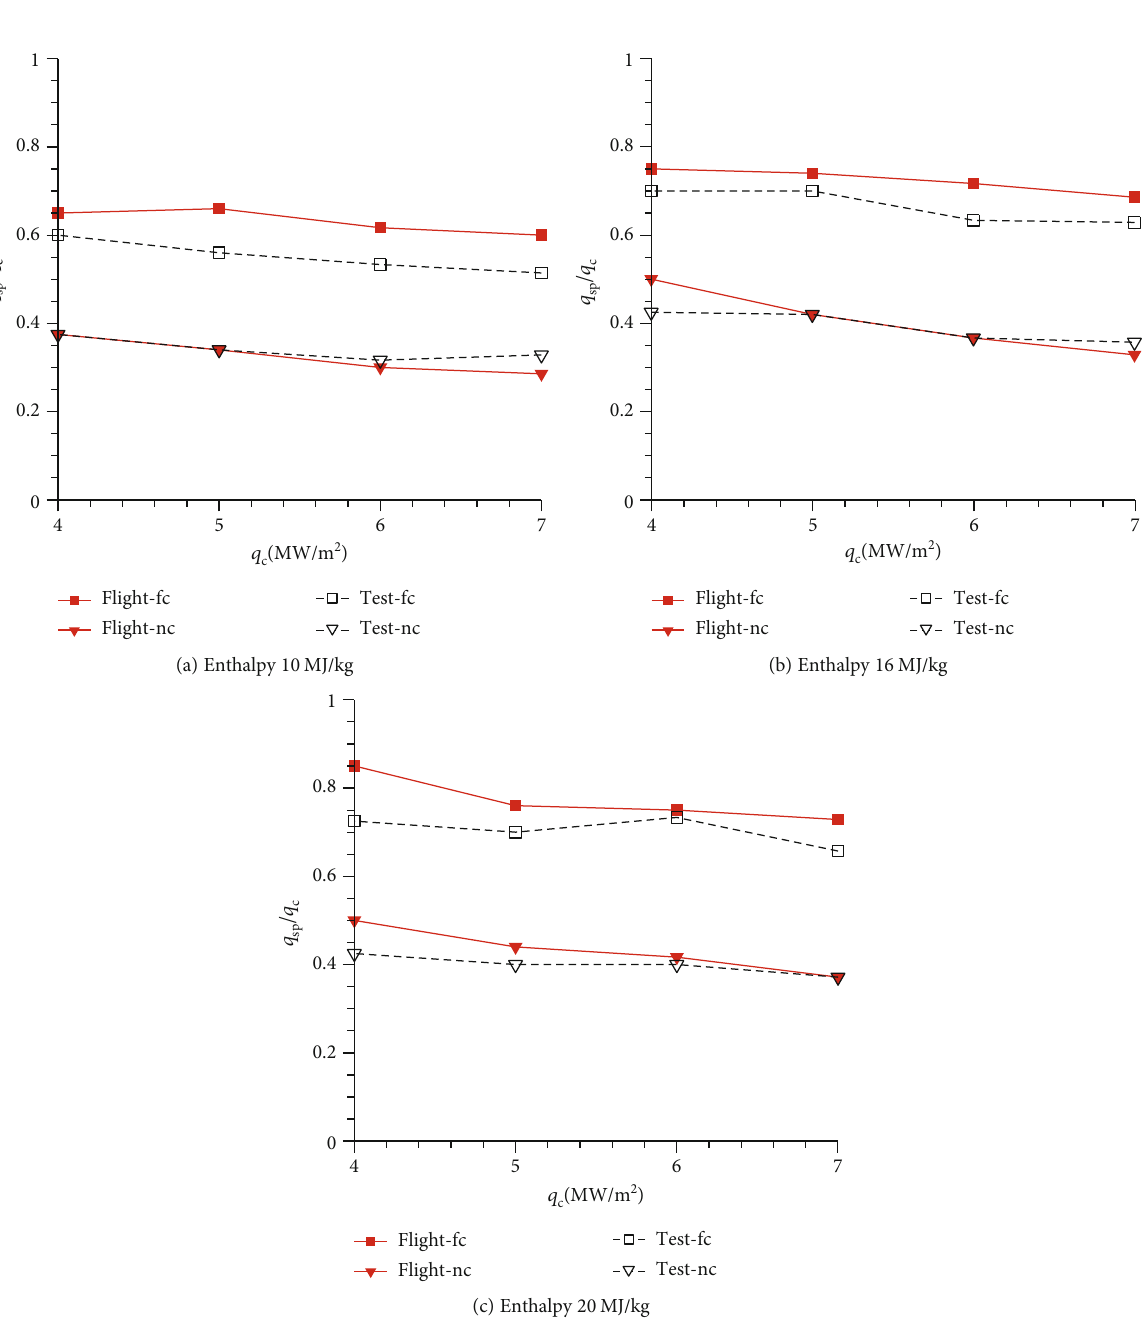
Figure 7: Comparison of the stagnation point heat fl ux with the radiation balance